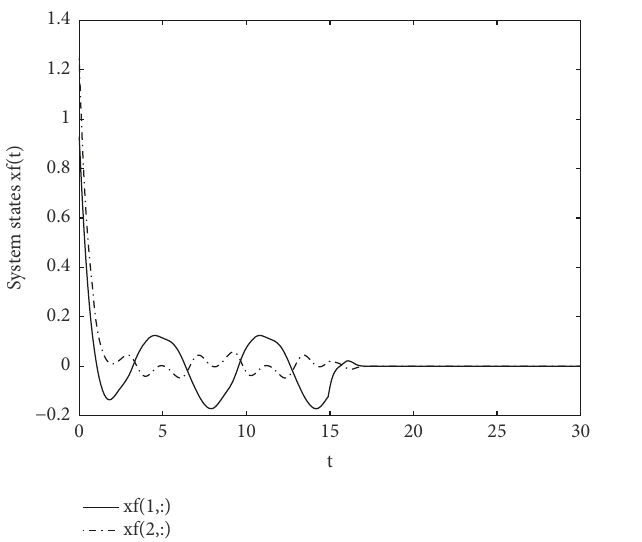
Figure 4: The response curve of vector 𝑒( t ) .